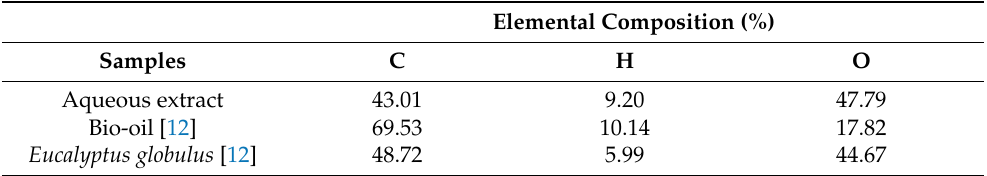
Table 1. Elemental analysis of the aqueous extract from eucalyptus globulus bio-oil.